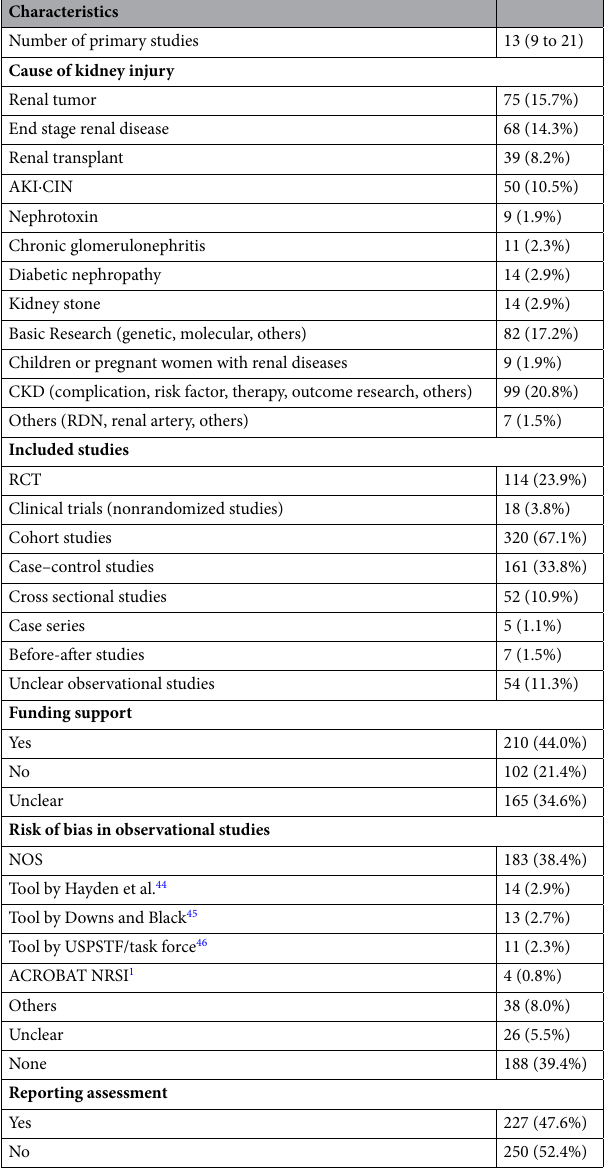
Table 1. Baseline characteristics of the 477 included systematic reviews of observational studies. Results of continuous variables are shown as the mean (standard deviation) or median (interquartile range). AKI